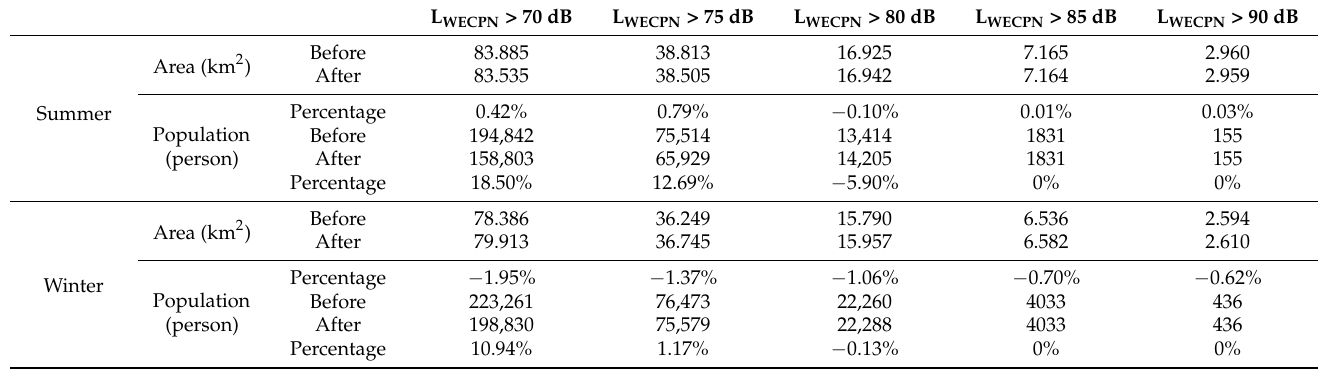
Table 4. Noise reduction effects by optimizing the flight procedure during summer and